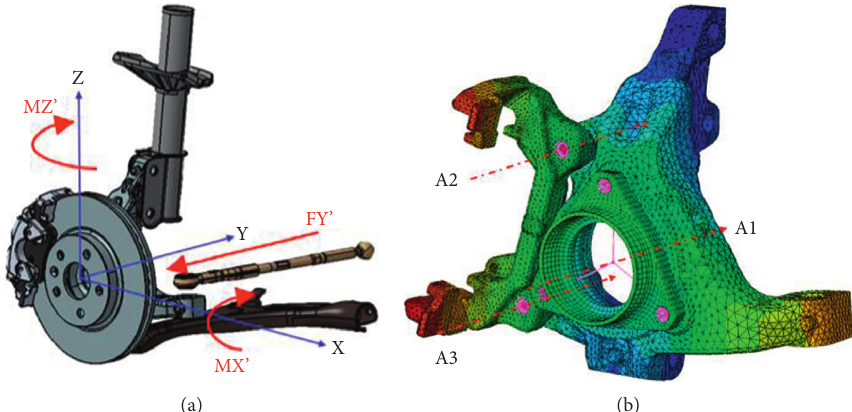
Figure 12: Influence of force and deformation of suspension on interface pressure distribution between the pads and disc. (a) Forces of the suspension system on the wheel center. (b) Deflection axis on knuckle.